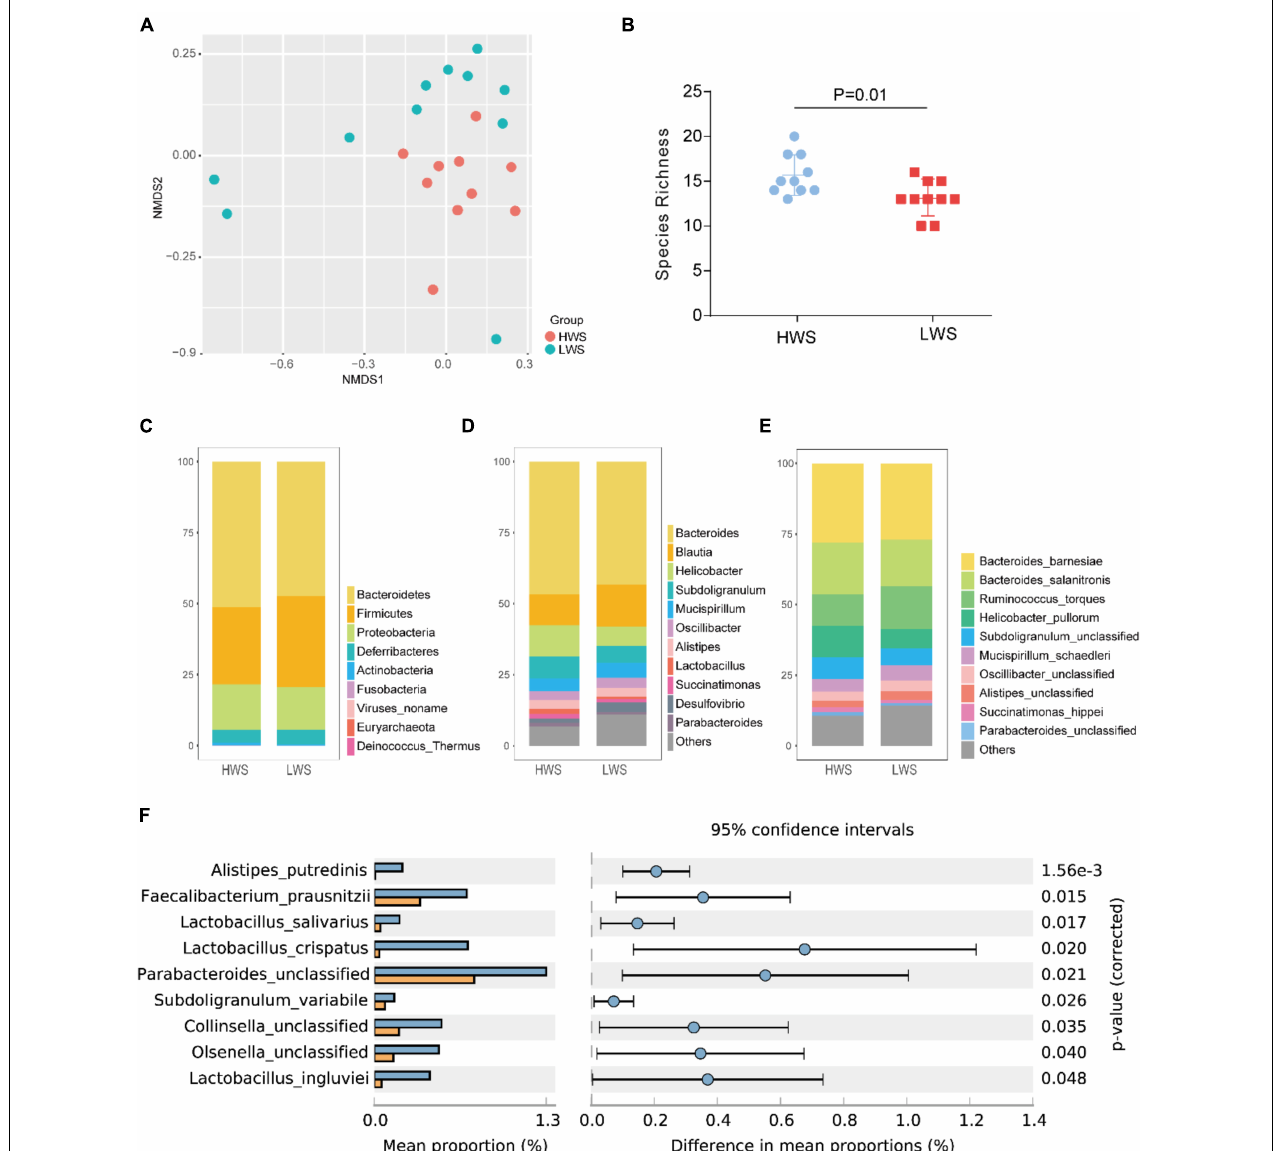
FIGURE 1 | The composition and structure of intestinal microbiota in HWS and LWS. (A) The NMDS plot of intestine bacterial profiles. (B) Intestinal bacteria species richness. (C) Composition of intestinal microbiota at the phyla level, (D) genus level, and (E) species level. Some low abundant intestinal bacteria were classified as “others” in (D,E) , detailed information of these intestinal bacteria was shown in Supplementary Table 2E (D) and Supplementary Table 2F (E) . (F) Comparisons of intestinal microbiota abundance at the species level in HWS and LWS. Blue and orange bars are HWS and LWS, respectively.